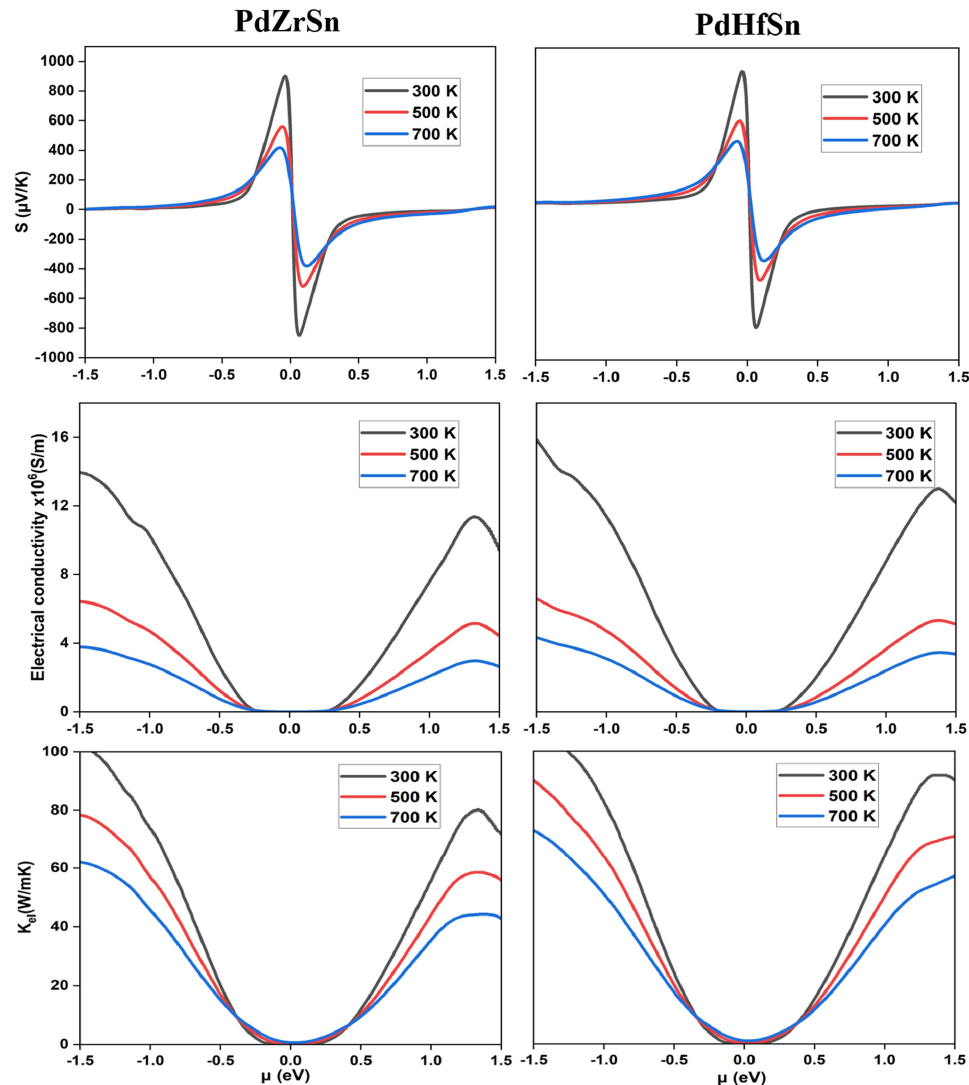
Figure 6. Seebeck coefficient and electrical conductivity and electronic part of thermal conductivity ( k el ) for both PdZrSn ( left panels) and PdHfSn ( right panels) materials at various temperature (300 K, 500 K, 700 K) as a function of chemical potential (µ).